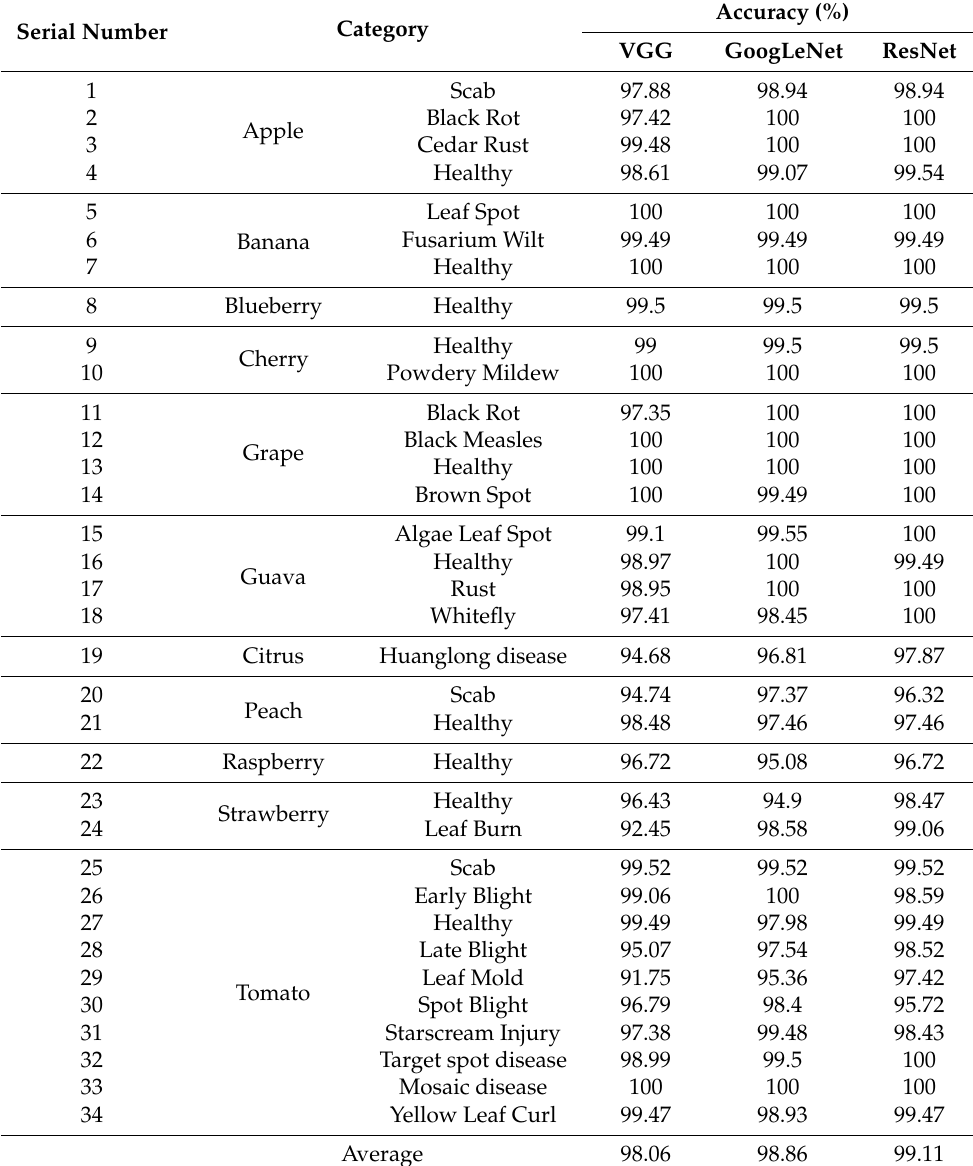
Table 3. The accuracy of the models on the test